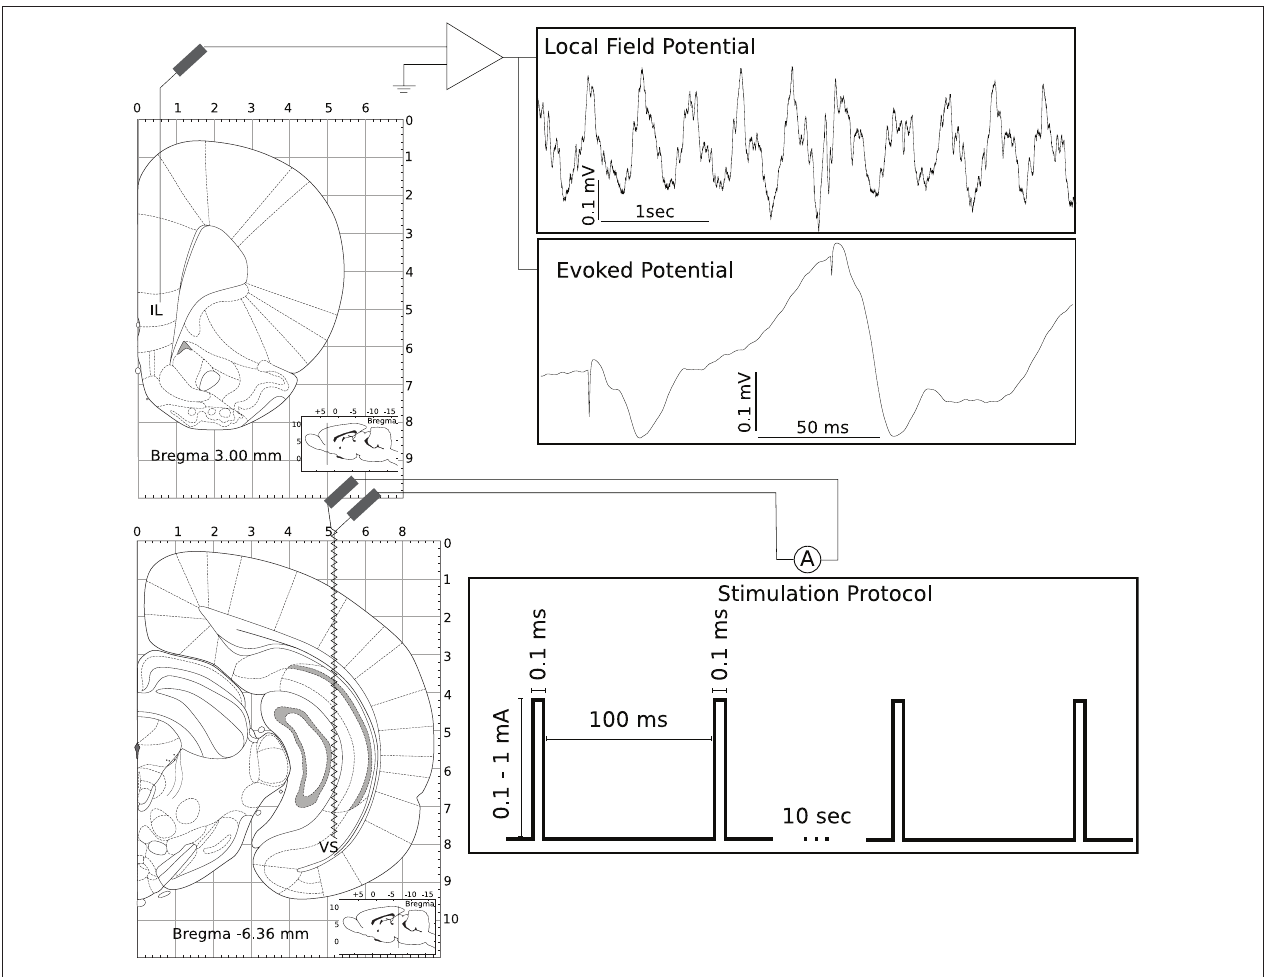
Figure 1 | experimental protocol for paired-pulse stimulation of the subiculum. For a detailed description see Section